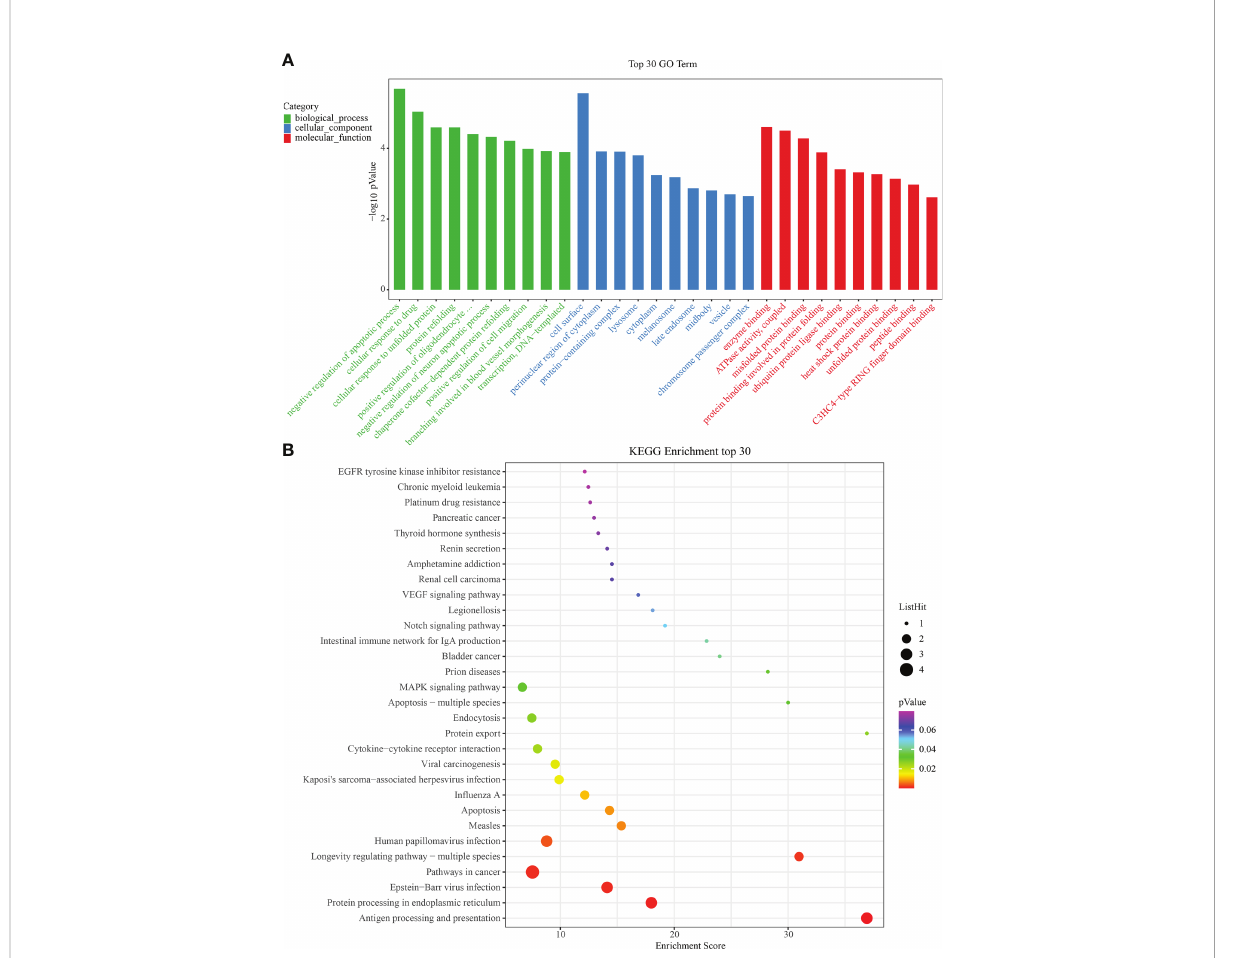
FIGURE 6 Gene ontology/Kyoto Encyclopedia of Genes and Genomes (GO/KEGG) enrichment results. (A) Bar graphs showing GO on BP (Biological Process), MF (Molecular Function) and CC (Cellular Component) levels. (B) Bubble diagram showing the enrichment results of KEGG